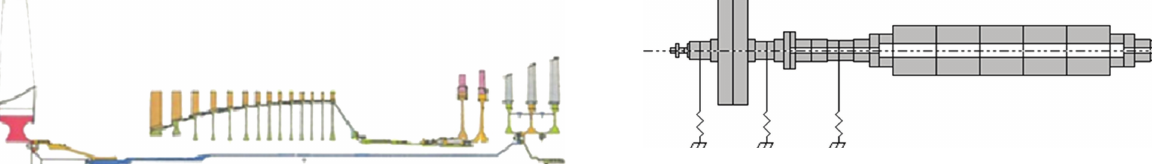
Figure 1: The low and high pressure shaft assembliesof a jet engine.